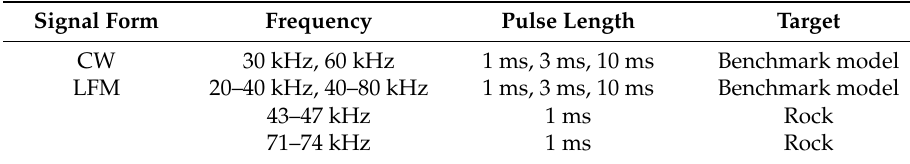
Table 1. Parameters of the incident